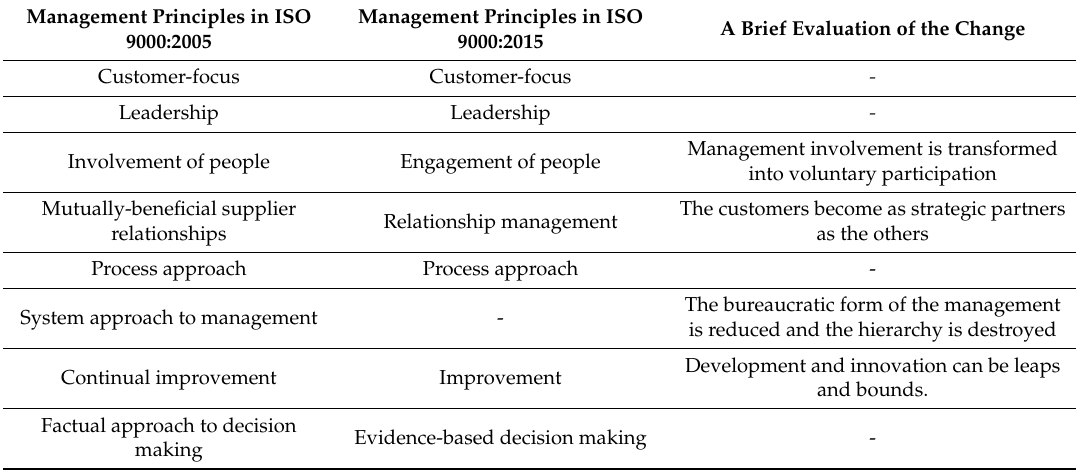
Table 1. Quality management principles of ISO 9000:2005 according to [21] and the main elements of ISO 9000:2015 according to